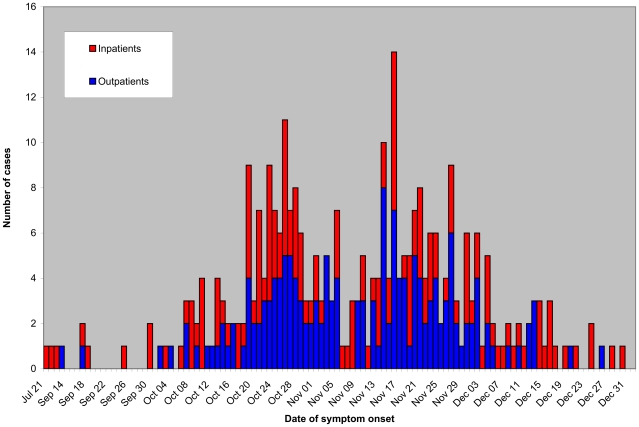
Temporal repartition of laboratory-confirmed 2009 A/H1N1v infection among pregnant women in the French registry according to patient status.